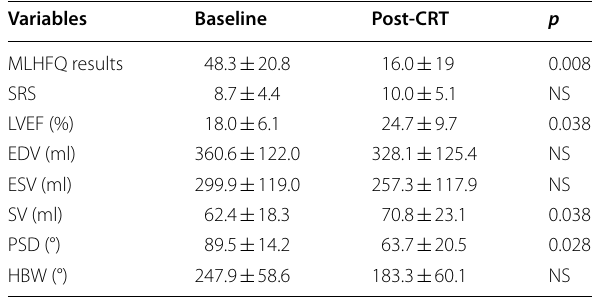
Table 2 Gated-SPECT Table 3 Comparison between baseline and 6-month follow-up in non-compaction cardiomyopathy patients (Group